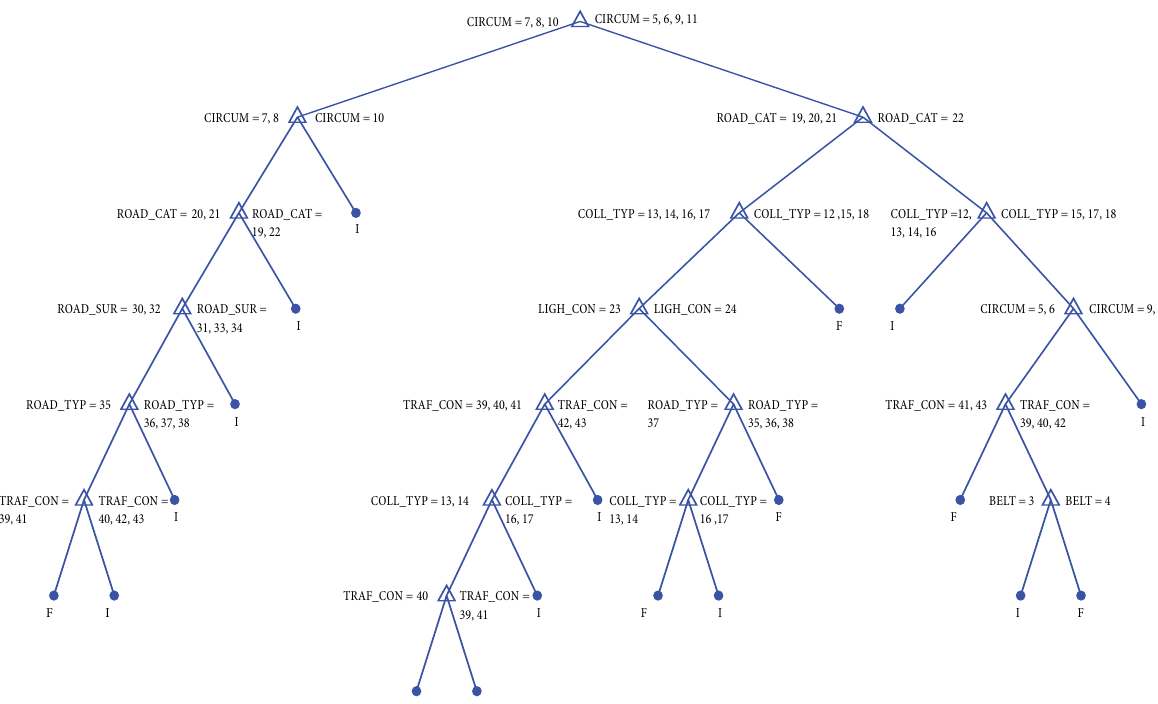
Fig. 2. Optimal size of the classification model to identify key patterns that cause injuries and fatalities in traffic accidents on Slovenian roads: I – injury; F –